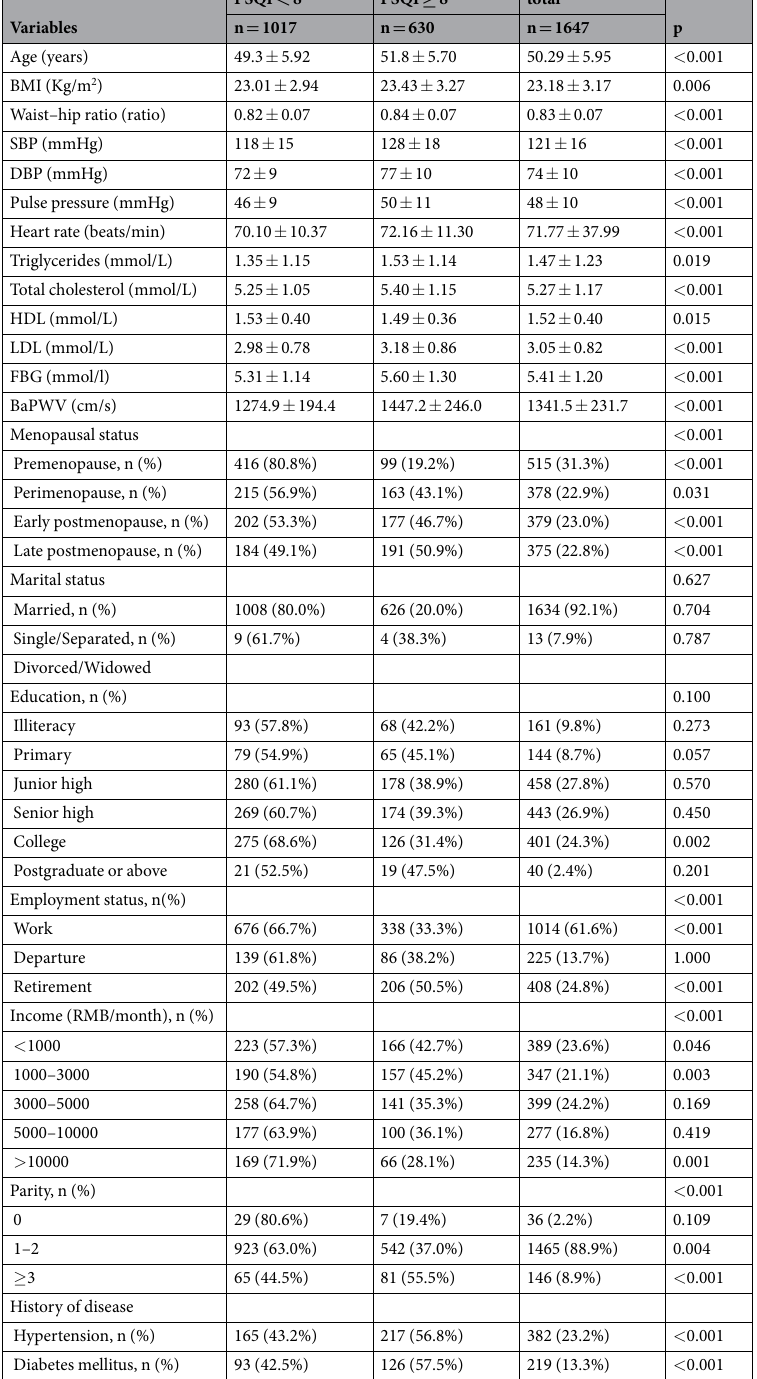
Table 1. Comparison of variables associated with two–score based groups. Data were expressed as mean ± SD or frequencies. All data were normally distributed. Age, height, BMI, WHR, SBP, DBP, PP, HR, TC didn’t satisfy the homogeneity of variance, and were analyzed by Mann–Whitney U test. Other continuous variables